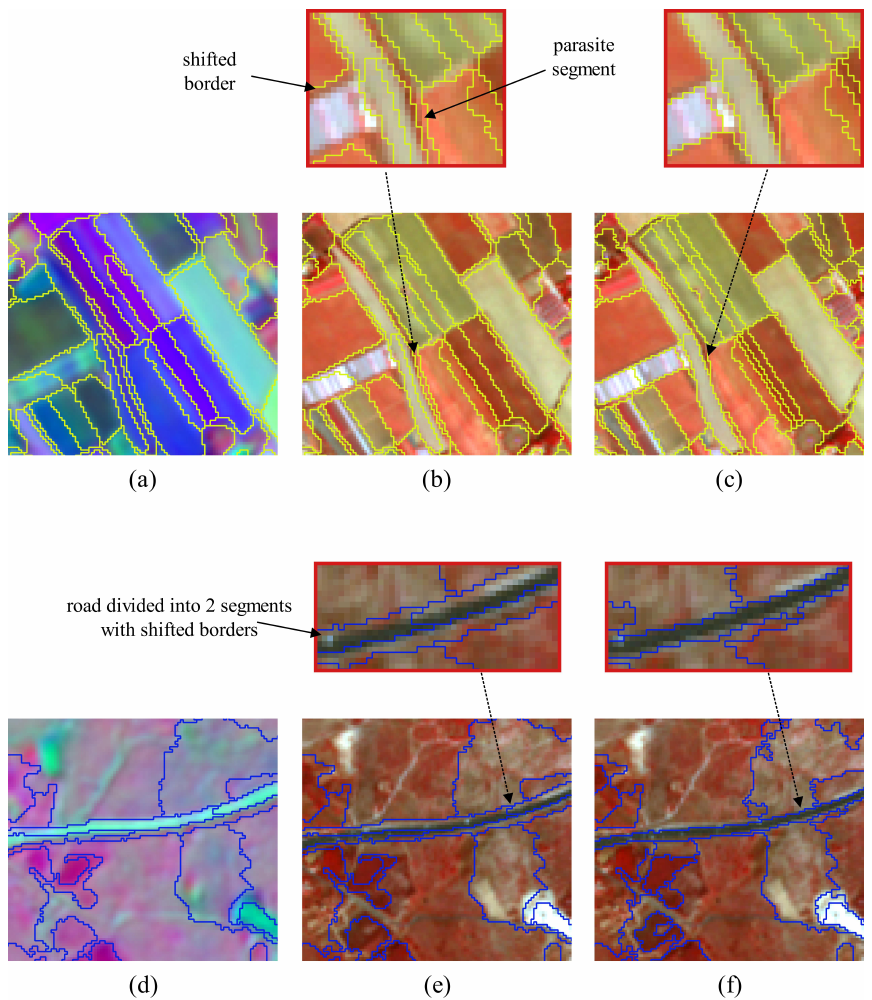
Figure 2. Influence of the border effect on the segmentation results and its eventual correction, example issued from SPOT-5 dataset (see dataset description in the following section). Top row–border effect in crops segmentation, bottom row–border effect in road segmentation. ( a , d )—encoded images and corresponding segmentations, ( b , e )–projection of these segmentations on the last image of the dataset, ( c , f )—images corrected for the border effect. Note that 10-feature encoded image is presented in the limits of 3 channel combination, original SPOT-5 image is presented in false